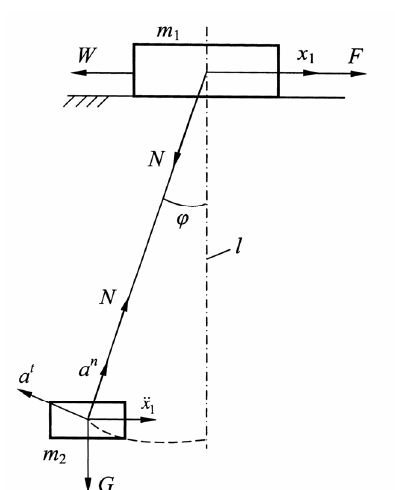
Fig 1. Rated scheme of a trolley with a